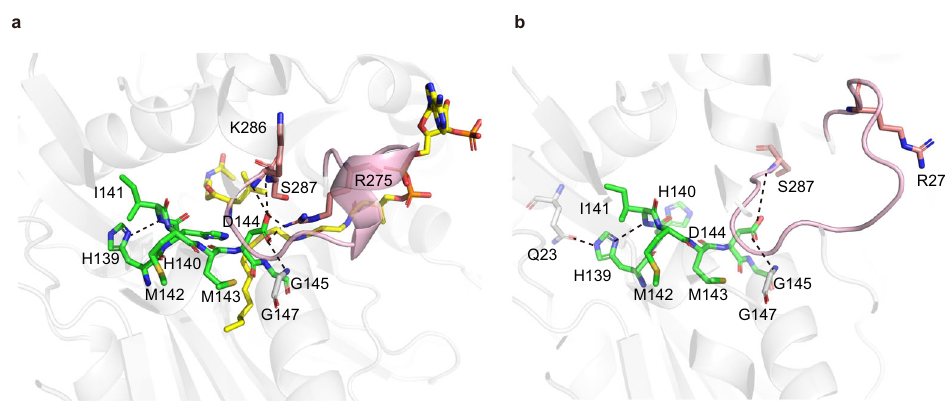
Fig. 10 Potential structure-stabilizing function of the conserved “ HHxxxDG ” motif. a As revealed by the co-complex structure of RzmA-Cs with two substrates, the side-chain of H139 interacts with the main chain of I141, and that of D144 interacts with the side-chain of R275 (to form a salt bridge) and the main chain atoms of G147, K286, and S287. b In the “ unbound ” structure of RzmA-Cs, most of the above residues interacting with H139 and D144 are at the similar positions, while the R275 residue of the “ fl oor ” region is far away from D144. The seven residues in the conserved “ HHxxxDG ” motif are colored in green, and the “ fl oor ” region is highlighted in light pink. The two bound substrates are colored yellow. All interactions are shown as black